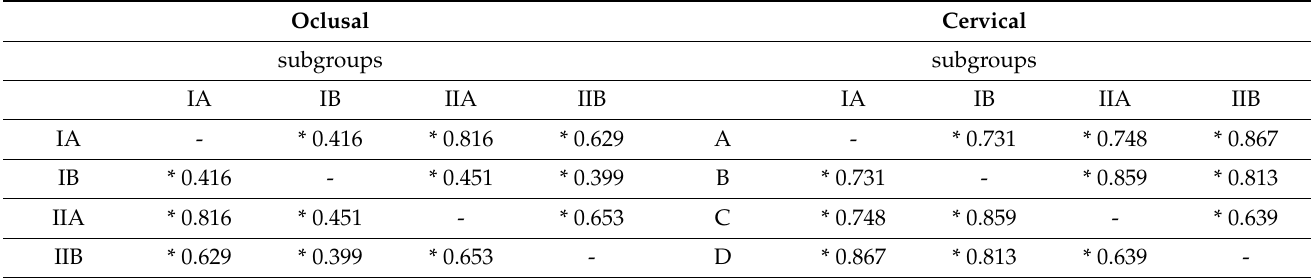
Table 3. Statistical differences between groups for occlusal/cervical margin.